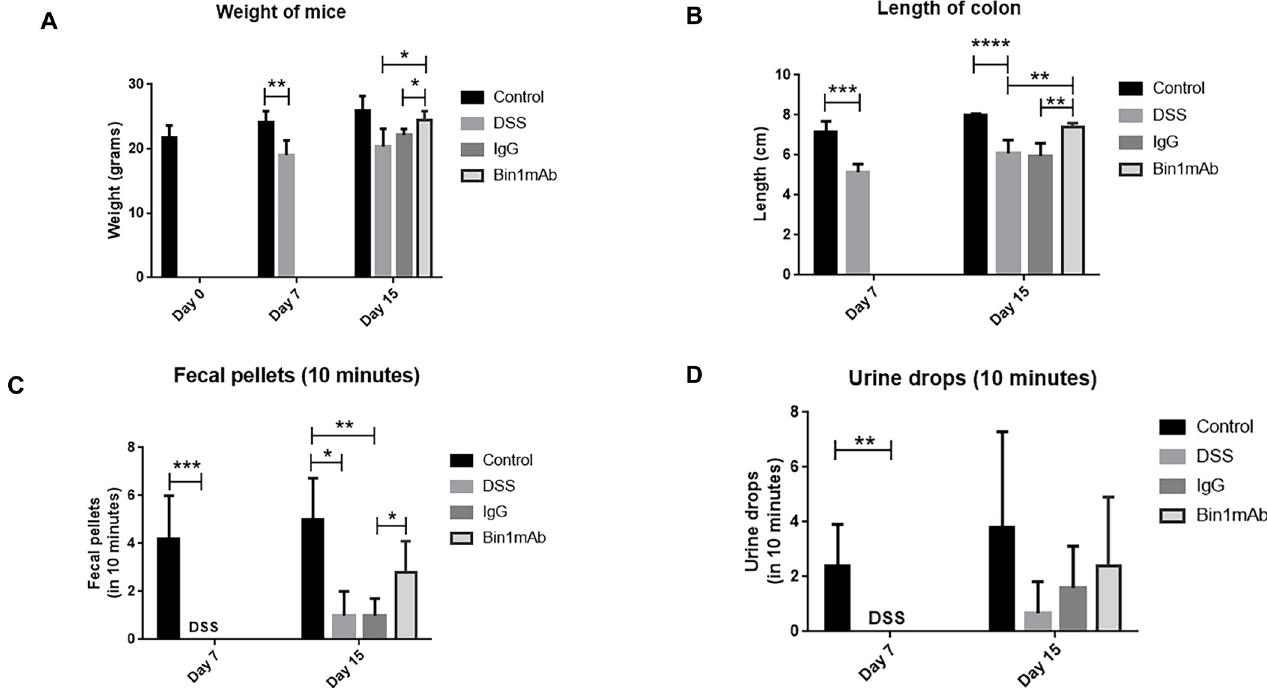
Fig 1. Phenotypic effects of Bin1 mAb treatment in DSS-treated mice. There was a change in (A) weight of mice, (B) length of colon, (C) the amount of fecal pellets, and (D) urine drops after treatment with Bin1 mAb after subjecting to DSS treatment ( � P < 0.05, �� P < 0.01, ��� P < 0.001, ���� P < 0.0001, as determined by t test). All results are expressed as Mean ± SD; (n = 5 mice per treatment). Fig 1A. Day 7: Control and DSS � p < 0.0038. Day 15: DSS and Bin1 mAb � p < 0.0285, IgG and Bin1mAb � p < 0.0156. Fig 1B. Day 7: Control and DSS � p < 0.0002, Day 15: Control and DSS � p < 0.0005, DSS and Bin1 mAb � p < 0.0057, IgG and Bin1 mAb � p < 0.0015. Fig 1C. Day 7: Control and DSS � p < 0.0008. Day 15: Control and DSS � p < 0.0116, Control and IgG � p < 0.0265. Fig 1D. Day 7: Control and DSS � p < 0.0076. Bin1, bridging integrator 1; DSS, dextran sodium sulfate; mAb, monoclonal antibodies.